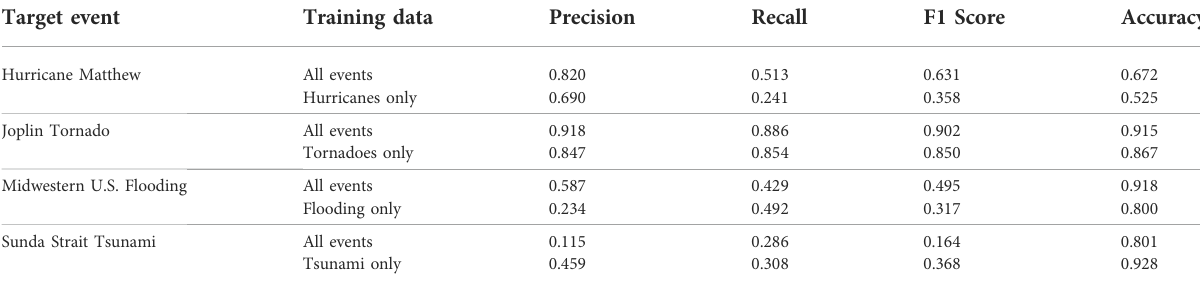
TABLE 4 Performance of our model in the out-of-domain